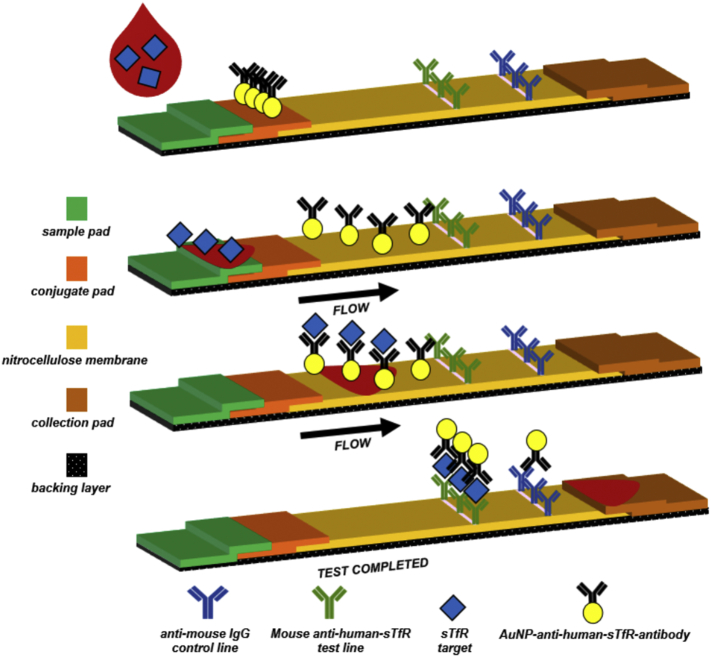
Schematic showing various components of test strip with a sandwich-type assay for sTfR detection.